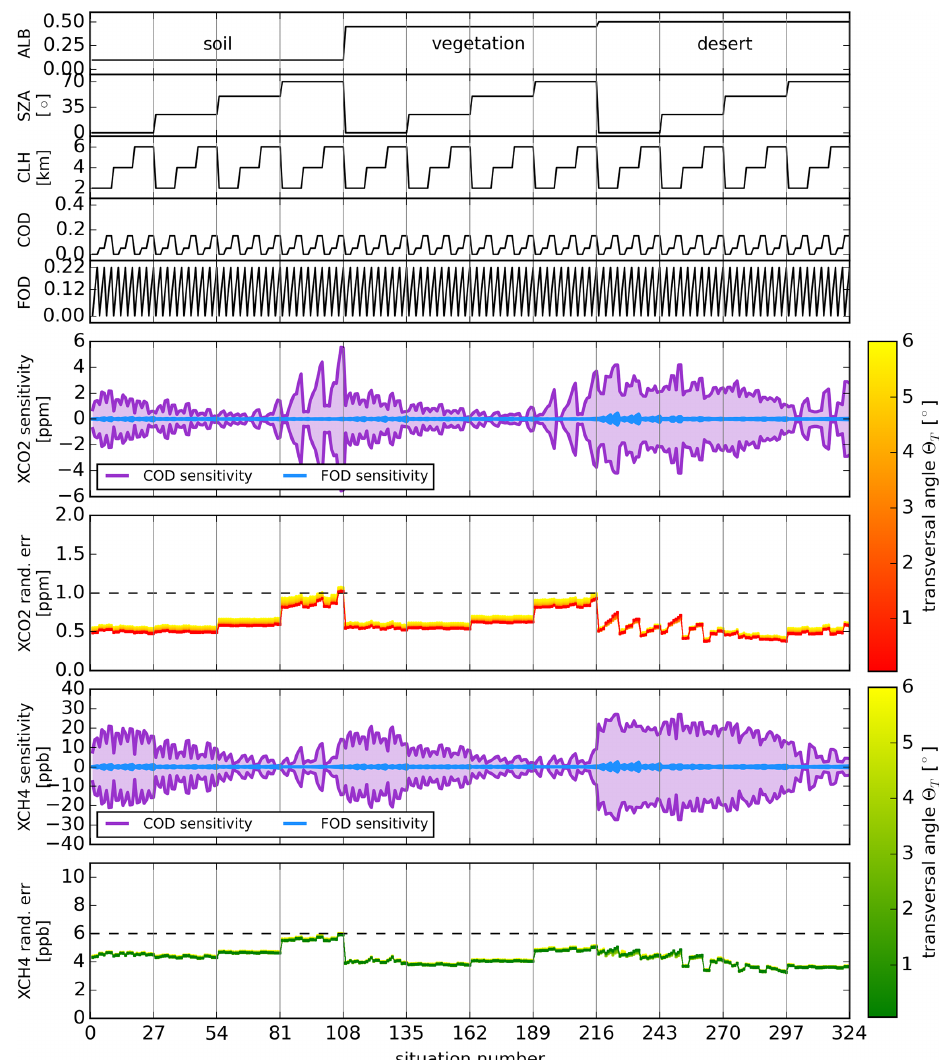
Figure 10. NanoCarb sensitivities to a priori misknowledge of COD and FOD and random errors for X CO design scenario case. Results are plotted as a function of the situation number: the five top panels detail the ALB (0.7µm), SZA, CLH, COD and FOD values defining all 324 situations. The sixth and seventh panels show X CO FOD and random errors, respectively, and the eighth and ninth panels show X CH and random errors, respectively. The dependence on the transversal angle θ T of random errors results is shown with the colour scales: darker colours correspond to lower θ T absolute values. As for sensitivities, only the minimum and maximum values for all transversal angles are